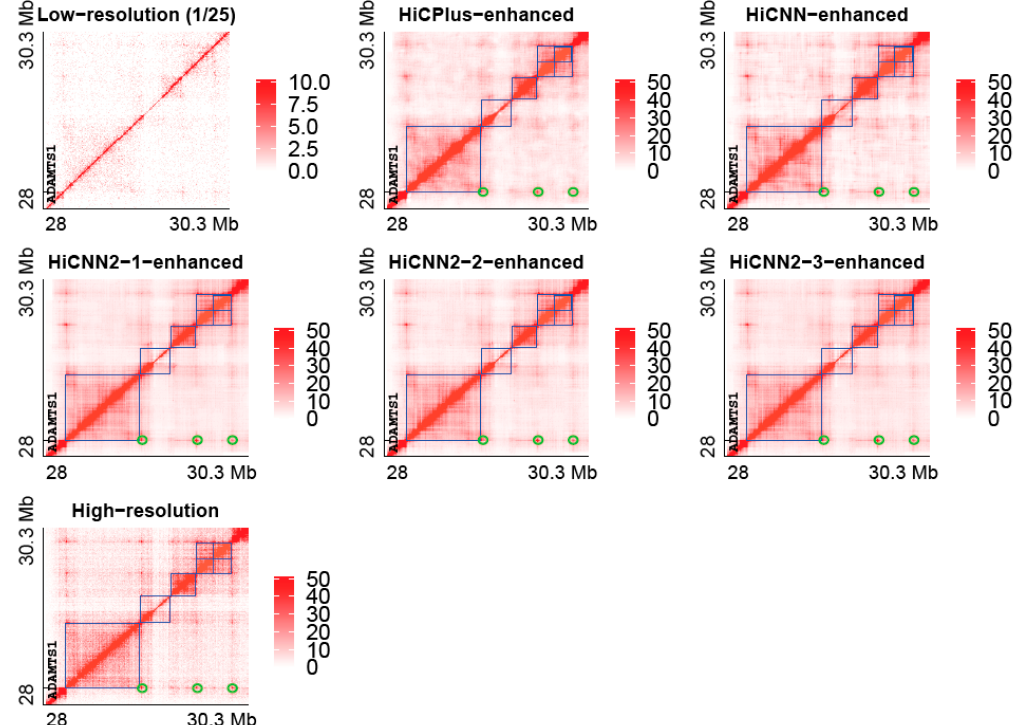
Figure 7. The heat maps of Hi-C contact matrices from low resolution (down sampling ratio 1/25), HiCPlus-enhanced, HiCNN-enhanced, HiCNN2-1-enhanced, HiCNN2-2-enhanced, and HiCNN2-3-enhanced, and real high-resolution Hi-C data on chromosome 21 (28–30.3 Mb) of human IMR90 cells. Six topologically associating domains (blue squares) and three Hi-C peaks (green circles) are highlighted in each of the predicted and real high-resolution heat maps (blue color). The models of the five methods were trained with input from GM12878 and with a down-sampling ratio equal to 1/25.